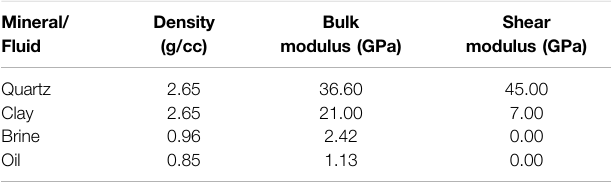
Frontiers in Earth Science |